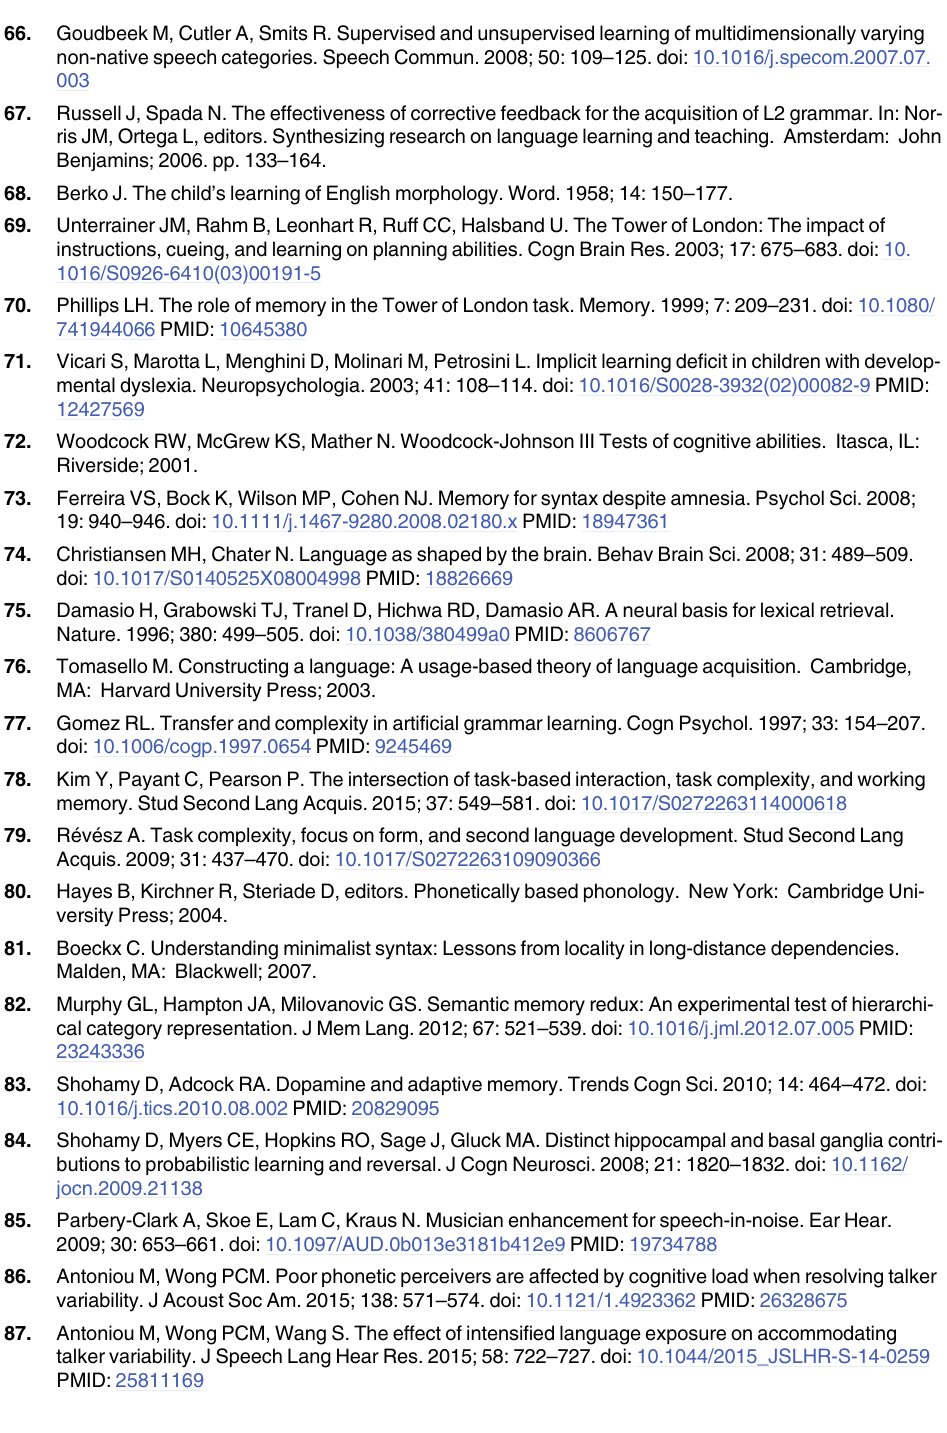
PLOS ONE | DOI:10.1371/journal.pone.0158812 July 8,